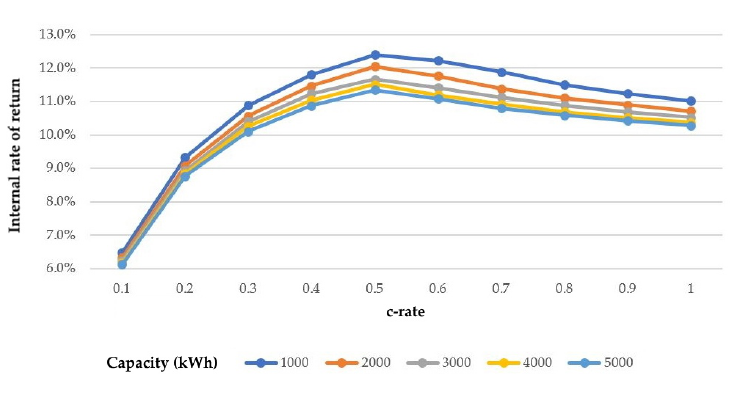
Figure A2. IRR estimation results for 2017 (MOO